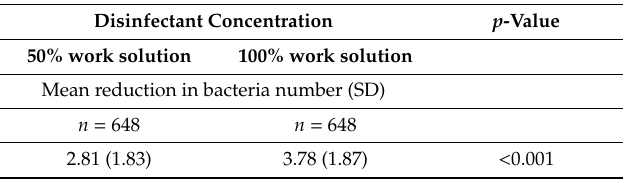
Table 5. The reductions of bacteria numbers recovered from biofilm for the examined concentrations of disinfectants.